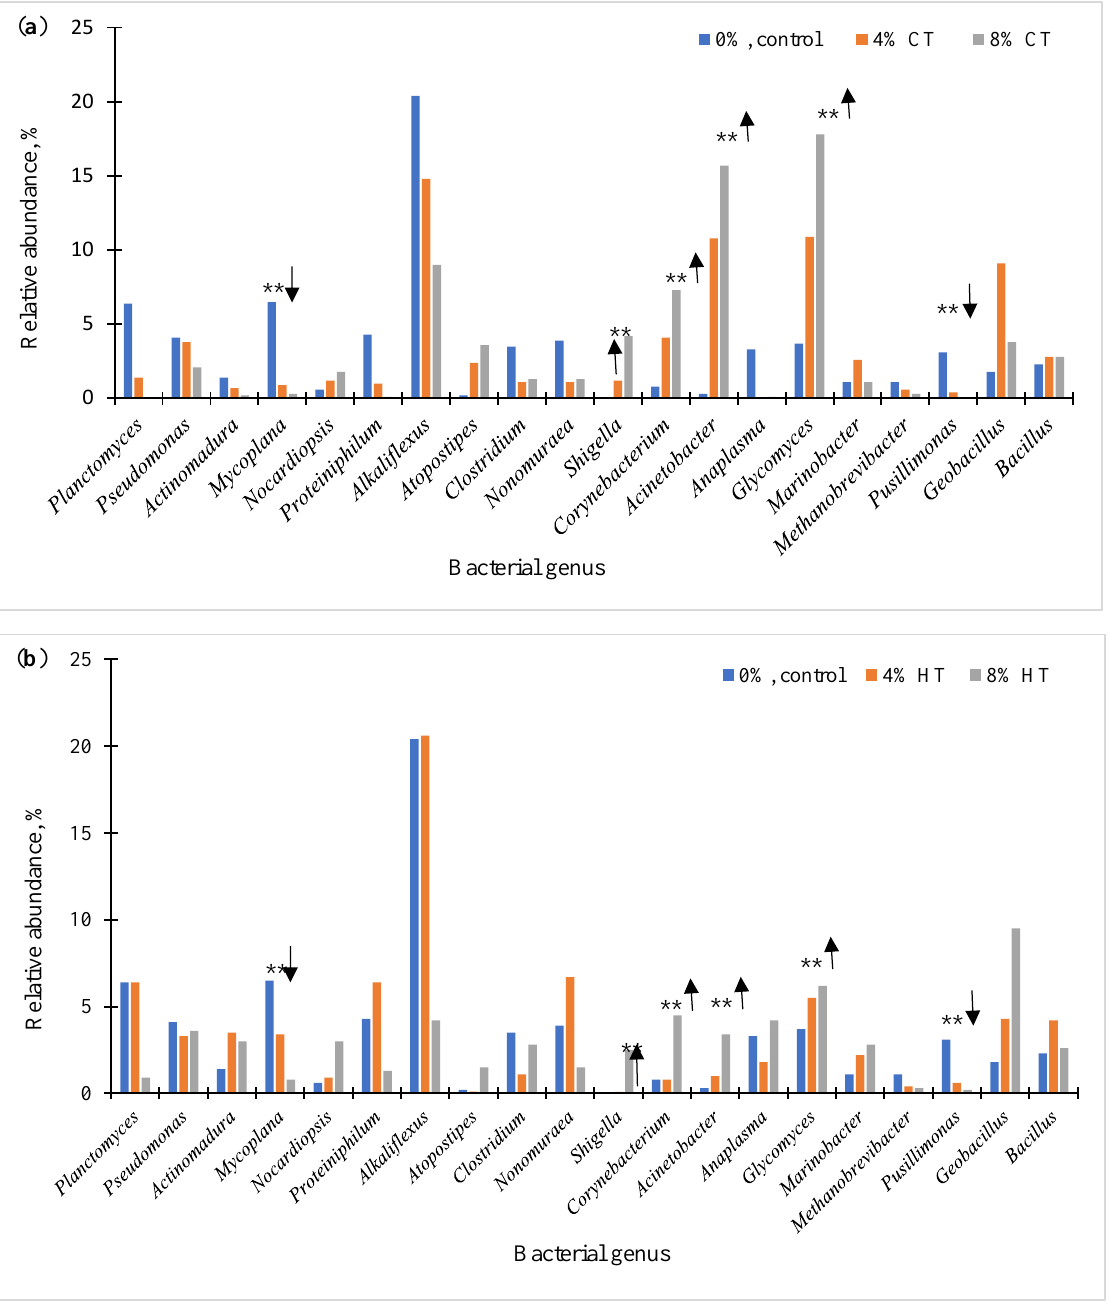
Figure 1. Genus-level classification of the bacterial community composition (n = 3) in condensed (CT; ( a )) and hydrolysable tannins (HT; ( b ); relative abundance >1.0%). Asterisks (**) represent significance levels of p < 0.01 with increased ( ↑ ) or decreased ( ↓ ) bacterial abundance.